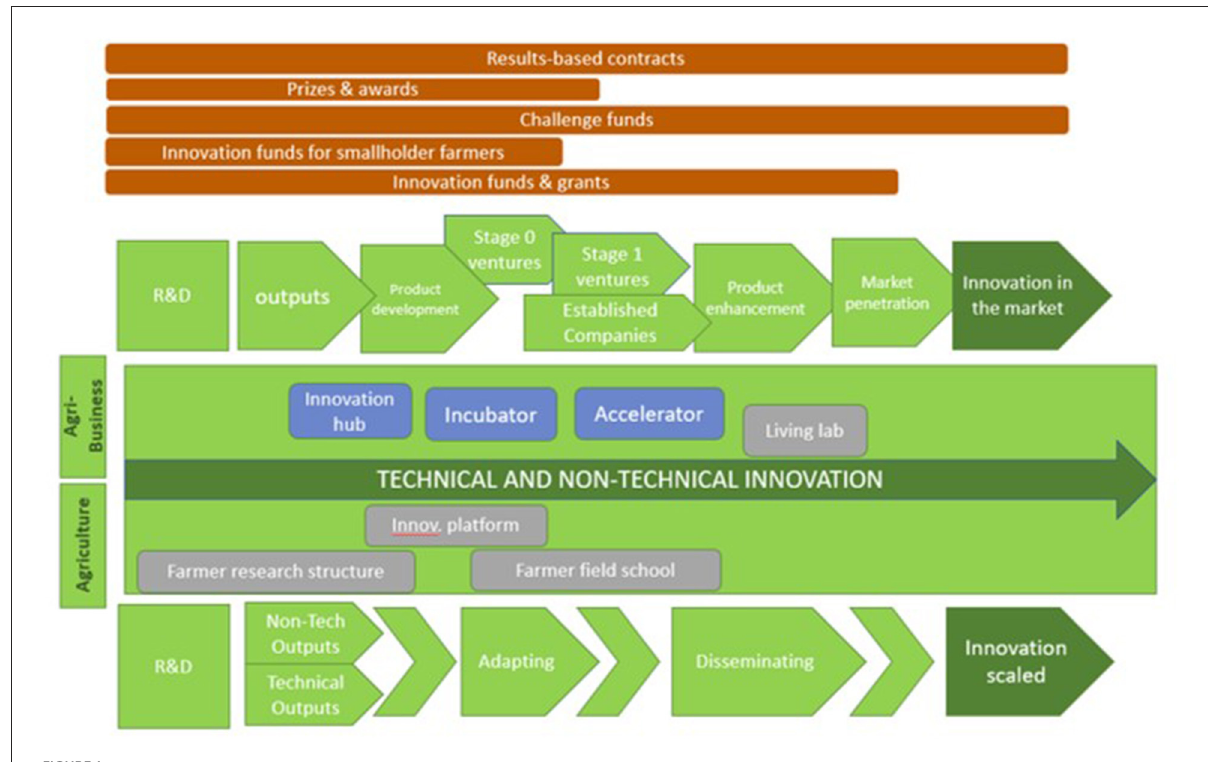
FIGURE1 Position of innovation instruments within the agricultural sector and along the innovation continuum (Type A in blue, Type B in brown and Type C in